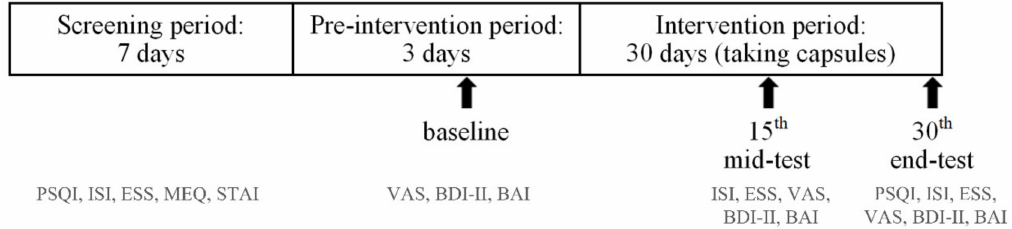
Figure 1. Study schedule. Participants underwent miniature-polysomnography at baseline, mid-test, and end-test. PSQI, Pittsburgh Sleep Quality Index; ISI, Insomnia Severity Index; ESS, Epworth Sleepiness Scale; BDI-II, Beck Depression Inventory-II; BAI, Beck Anxiety Inventory; STAI, State-Trait Anxiety Inventory State; MEQ, Morningness-Eveningness Questionnaire; VAS, Visual Analogue